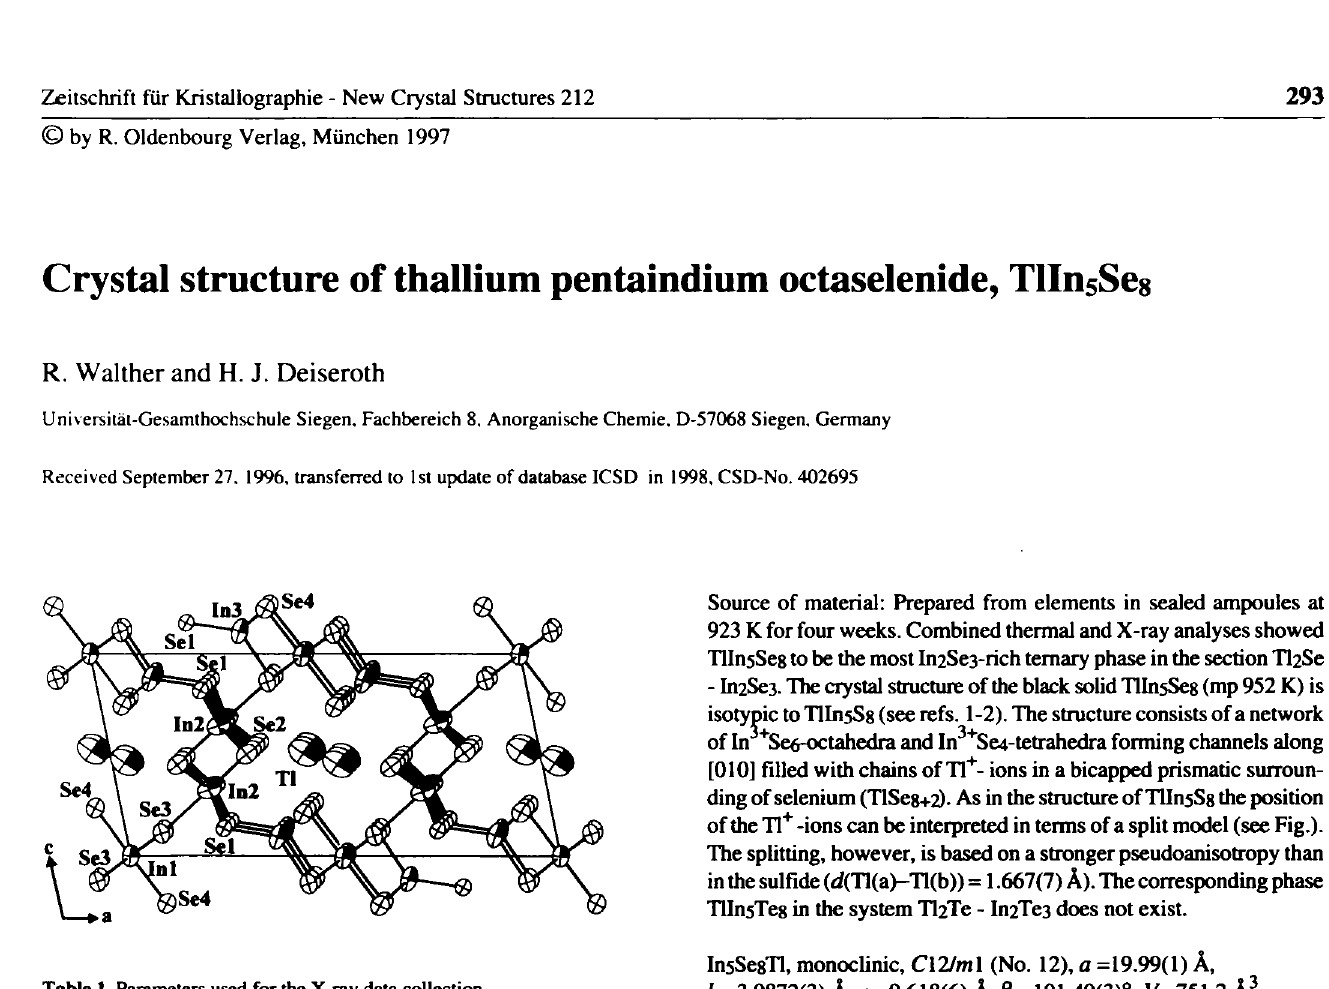
Table I. Parameters used for the X-ray data collection Crystal: